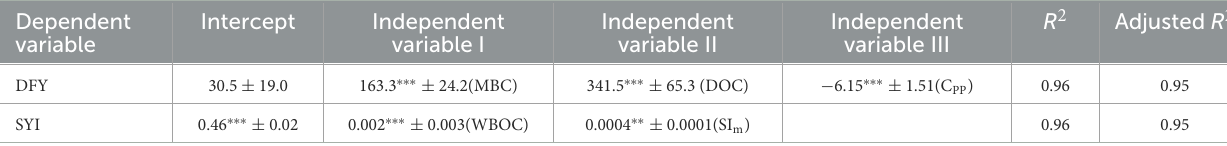
TABLE 7 Regression (backward elimination models) between soil parameters and dependent